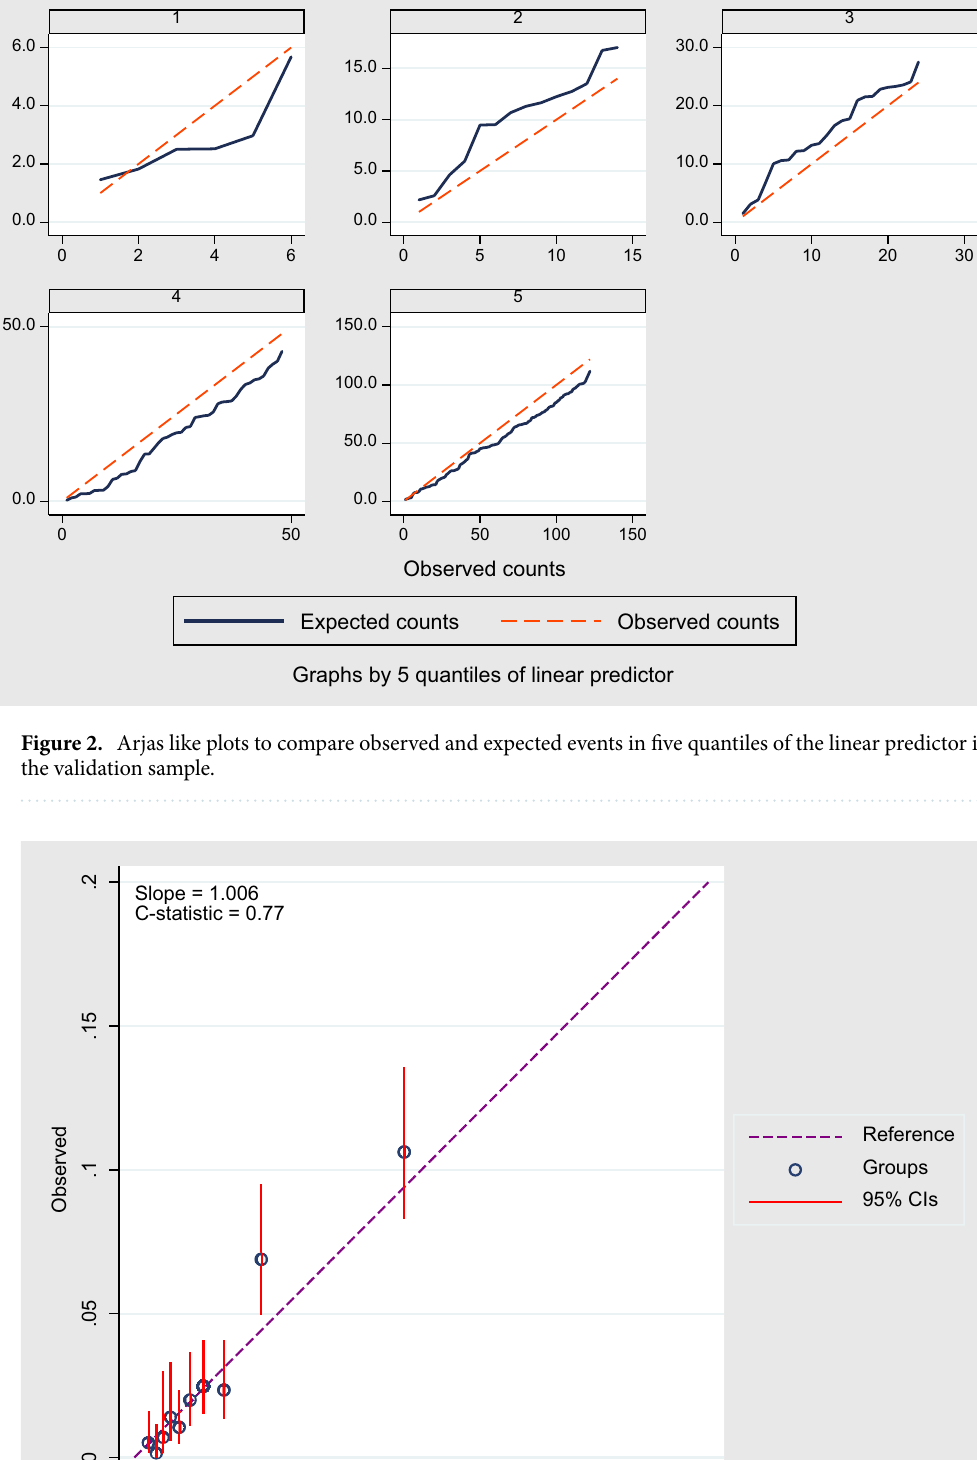
Figure 3. Calibration plot where expected probabilities (predicted probabilities from the model) are plotted against observed outcome probabilities (calculated by Kaplan–Meier